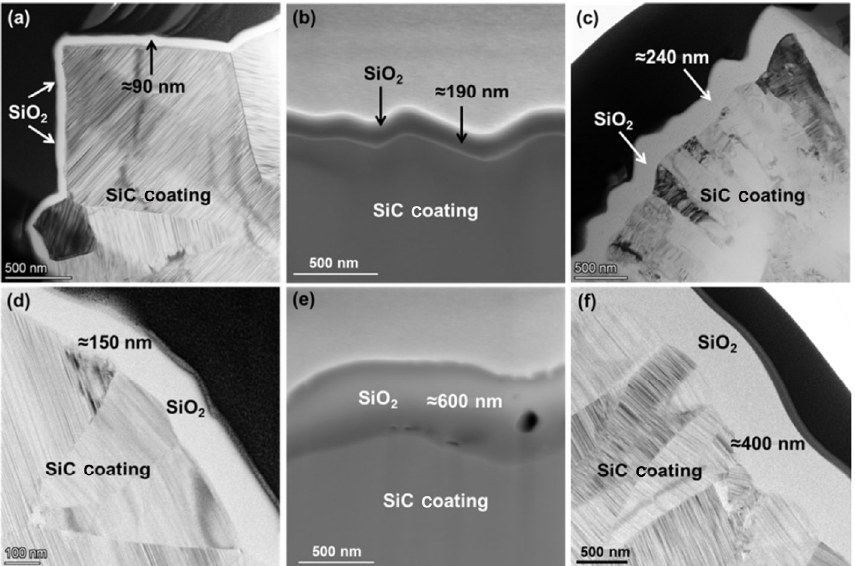
Fig. 10 Microstructures of SiO 2 layers oxidized on the SiC coating after multiple plasma exposures at (a–c) ~1100 ℃ and (d–f) ~1270 ℃ for 1, 5, and 10 times,